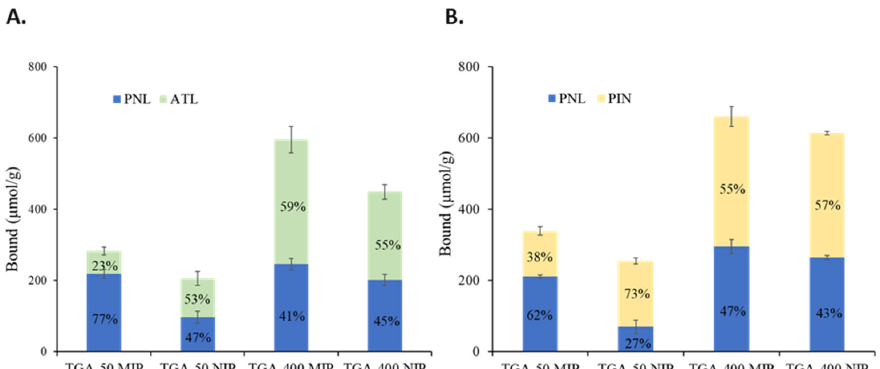
Figure 5. Binary competitive binding results for the PNL binding of the TGA-50 MIP/NIP and the TGA-400 MIP/NIP against ATL and PIN. A total of 2 mg of the polymer was incubated in a 1.0 mL mixture of the 2 mM PNL + 2 mM ATL ( A ) and 2 mM PNL + 2 mM PIN ( B ) solutions for 2 h.